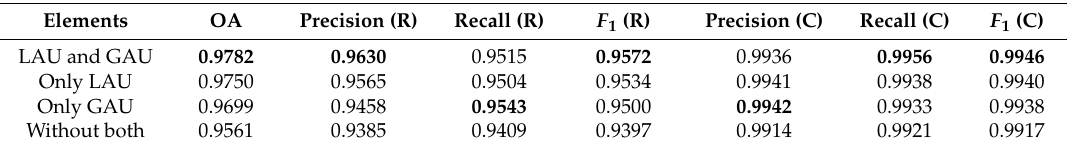
Table 3. Comparison of the results while excluding either the LAU or the GAU, where the values in bold are the